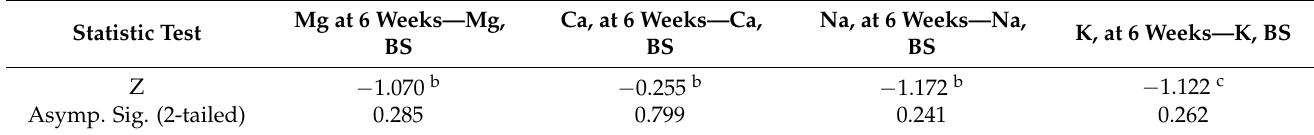
Table 9. Statistical comparison of serum electrolytes (SE) such as Mg, Ca, Na, and K before and 6 weeks after surgery.